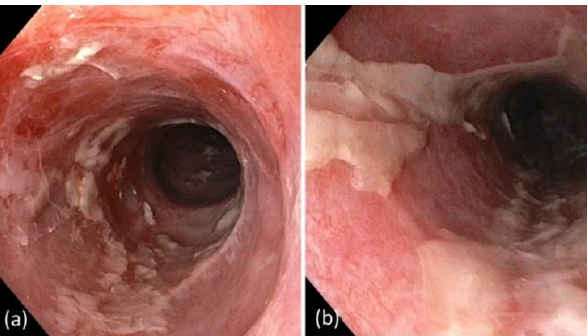
Figure 5. ( a ) Endoscopy of the esophagus revealing severe inflammation and contact-vulnerable mucosa along the entire esophagus, accompanied by erosions and massive fibrinoid deposits ( b ). Because of the marked mucosal vulnerability, biopsies were not performed.